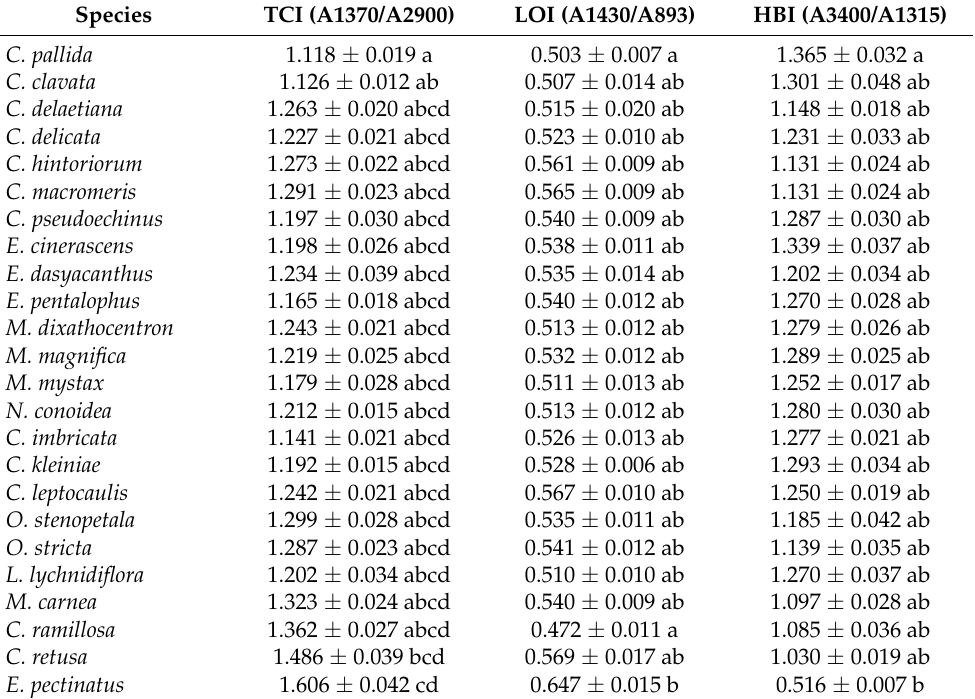
Table 4. Crystallinity indexes with standard deviations, to determine the crystalline cellulose of the 25 Cactaceae